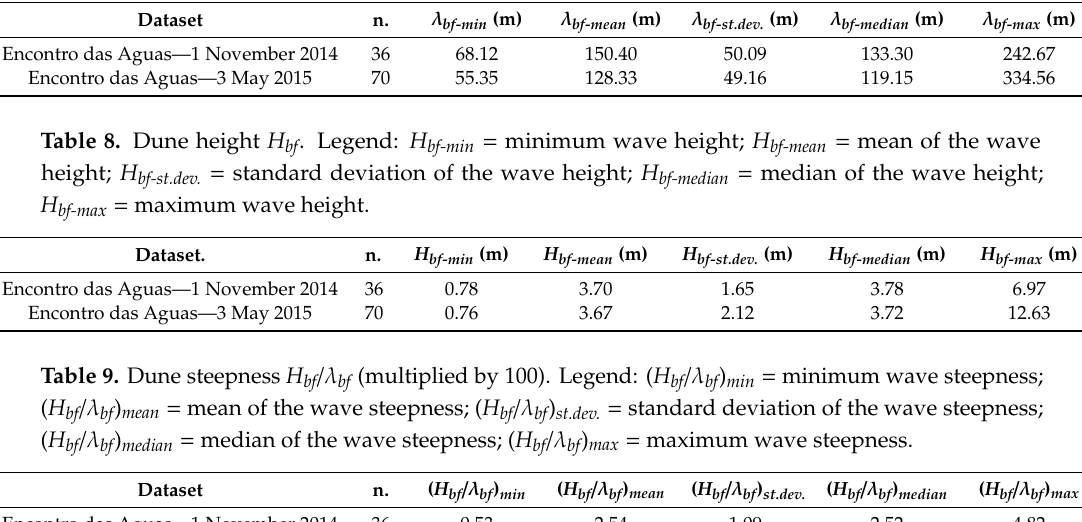
Table 7. Wavelength λ bf . Legend: λ bf - min = minimum wavelength; λ bf-mean = mean of the wavelength; λ bf-st.dev = standard deviation of the wavelength; λ bf-median = median of the wavelength; λ bf-max = maximum wave length.